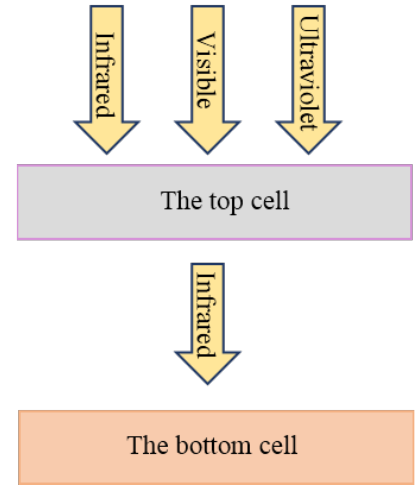
Figure 9: Principle of the tandem